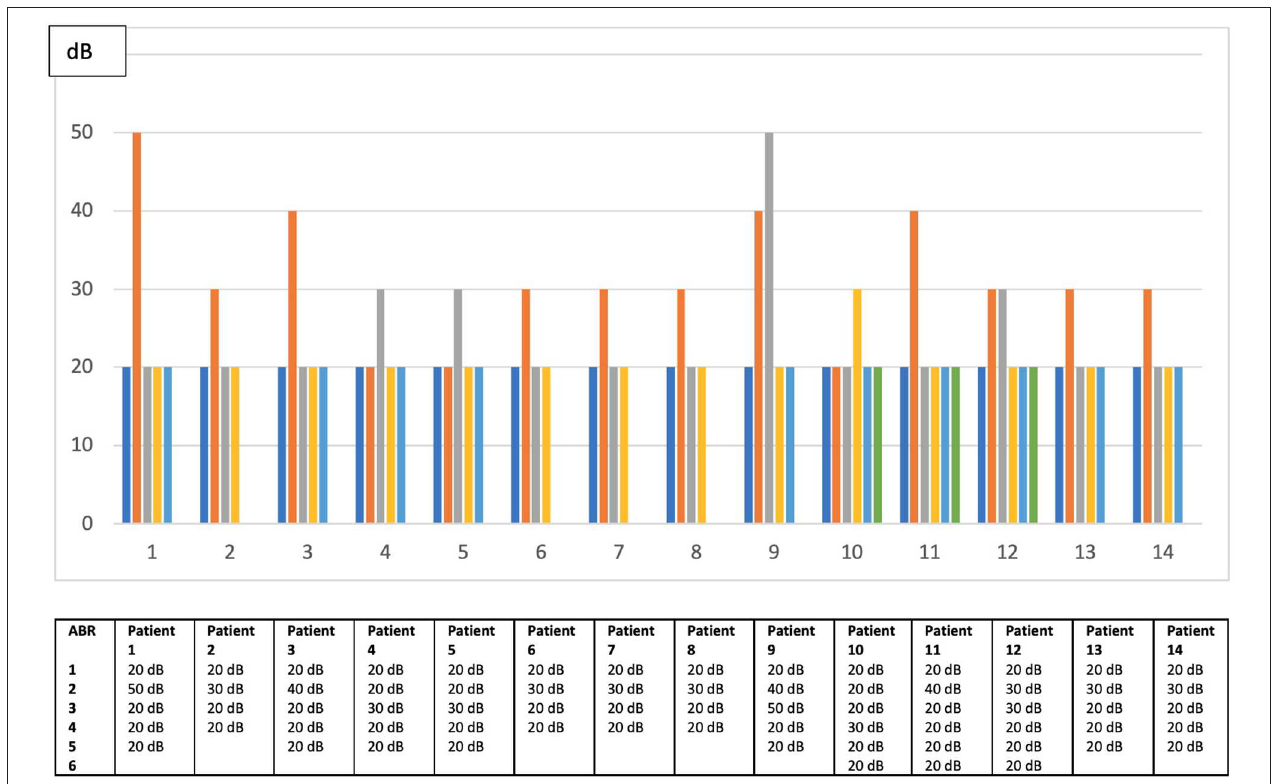
FIGURE 2 | Fluctuations of hearing threshold among patients with delayed unstable hearing loss in worst ear.